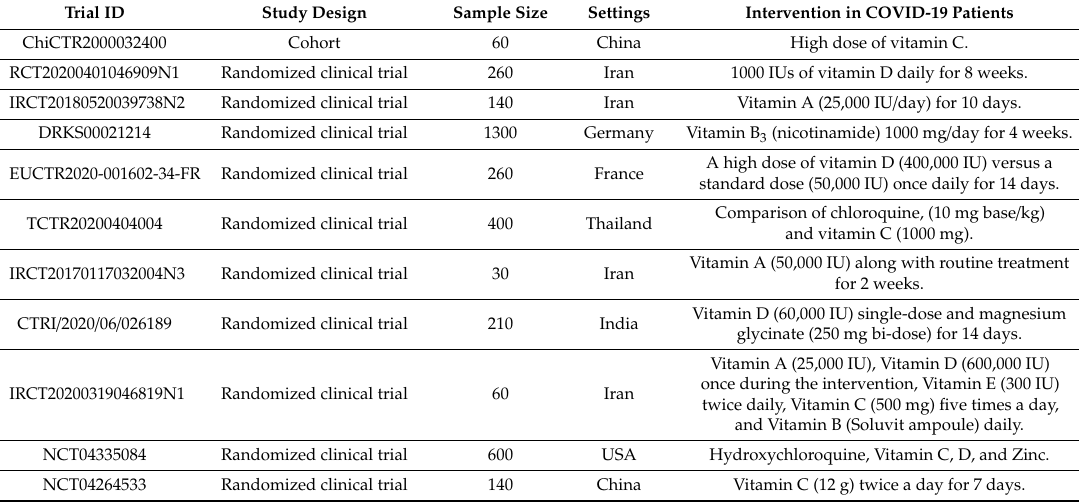
Table 1. Examples of clinical trials on the use of vitamins against COVID-19 registered by the WHO